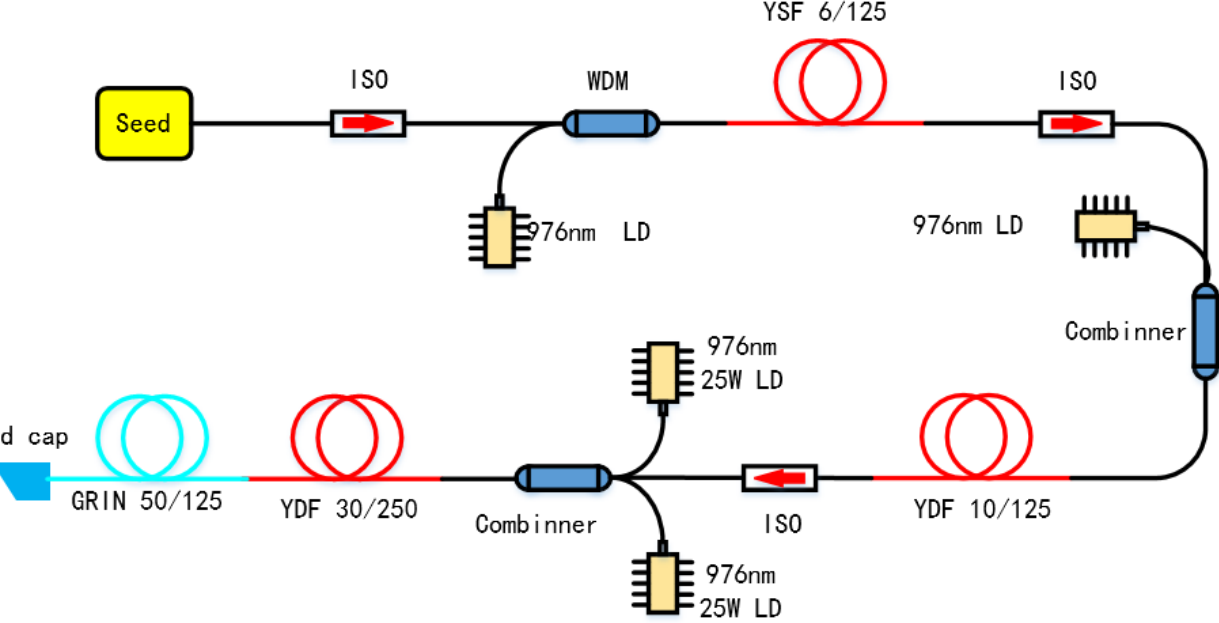
Figure 1. Schematic of the supercontinuum system. WDM: wavelength-division multiplexer, LD: laser diode, ISO: isolator, and YSF: Yb-doped single-mode fiber.